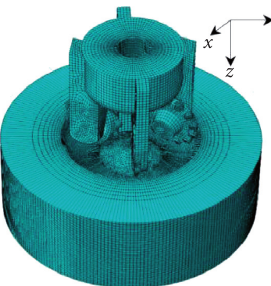
Figure 9: The finite element model of the novel PDC